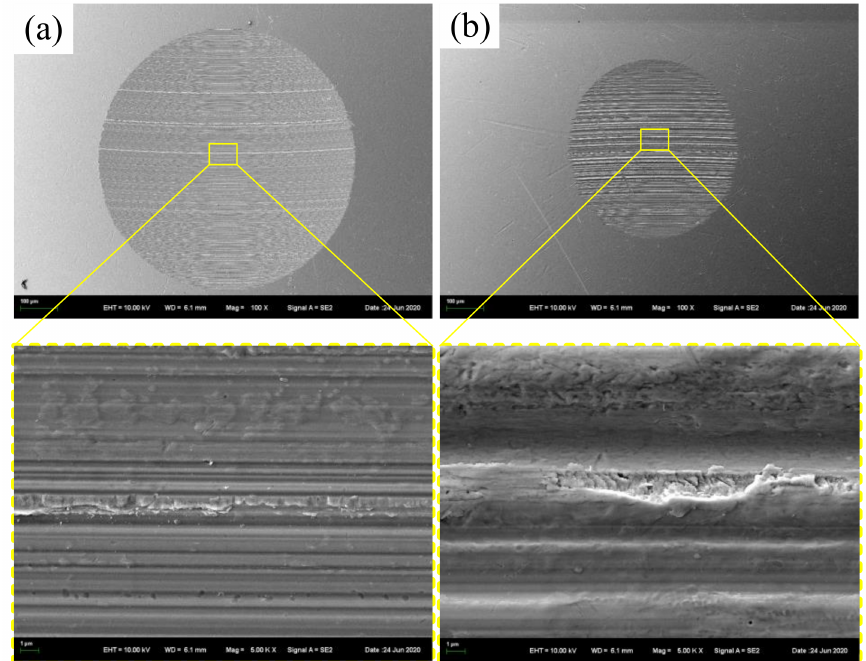
Figure 13. SEM images of wear scars after lubrication with IRIS and LSMLO. ( a ) IRIS; ( b )